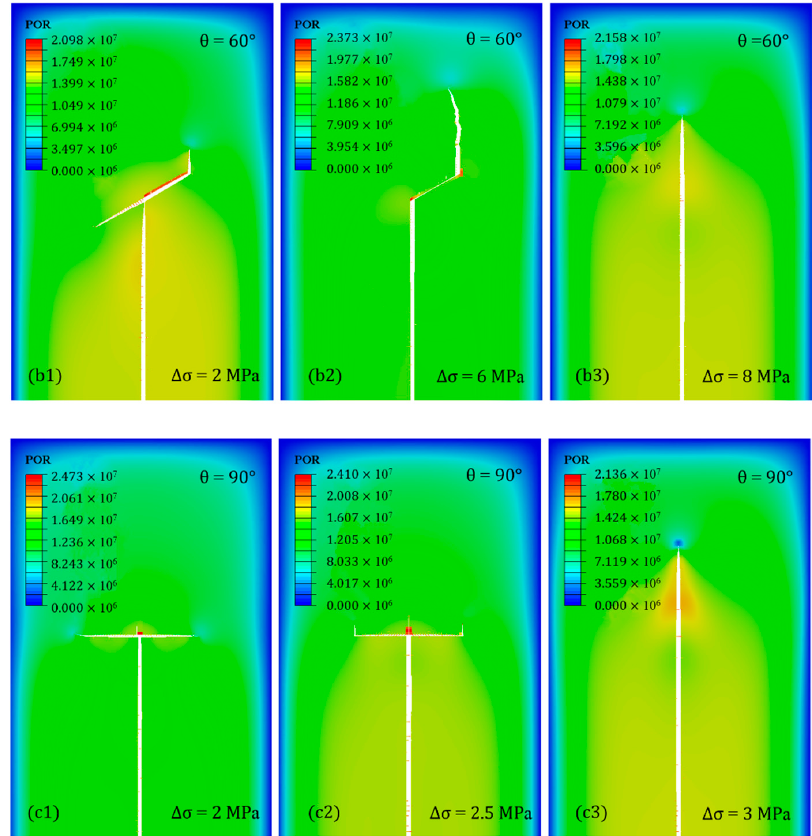
Figure 6. Effect of approaching angle and stress difference on hydraulic fracture propagation. ( a1–a3 ) Approaching angle = 45°: stress difference = 2, 8, and 12 MPa, respectively; ( b1–b3 ) approaching angle = 60°: stress difference = 2, 6, and 8 MPa, respectively; ( c1–c3 ) approaching angle = 90°: stress difference = 2, 2.5, and 3 MPa, respectively.